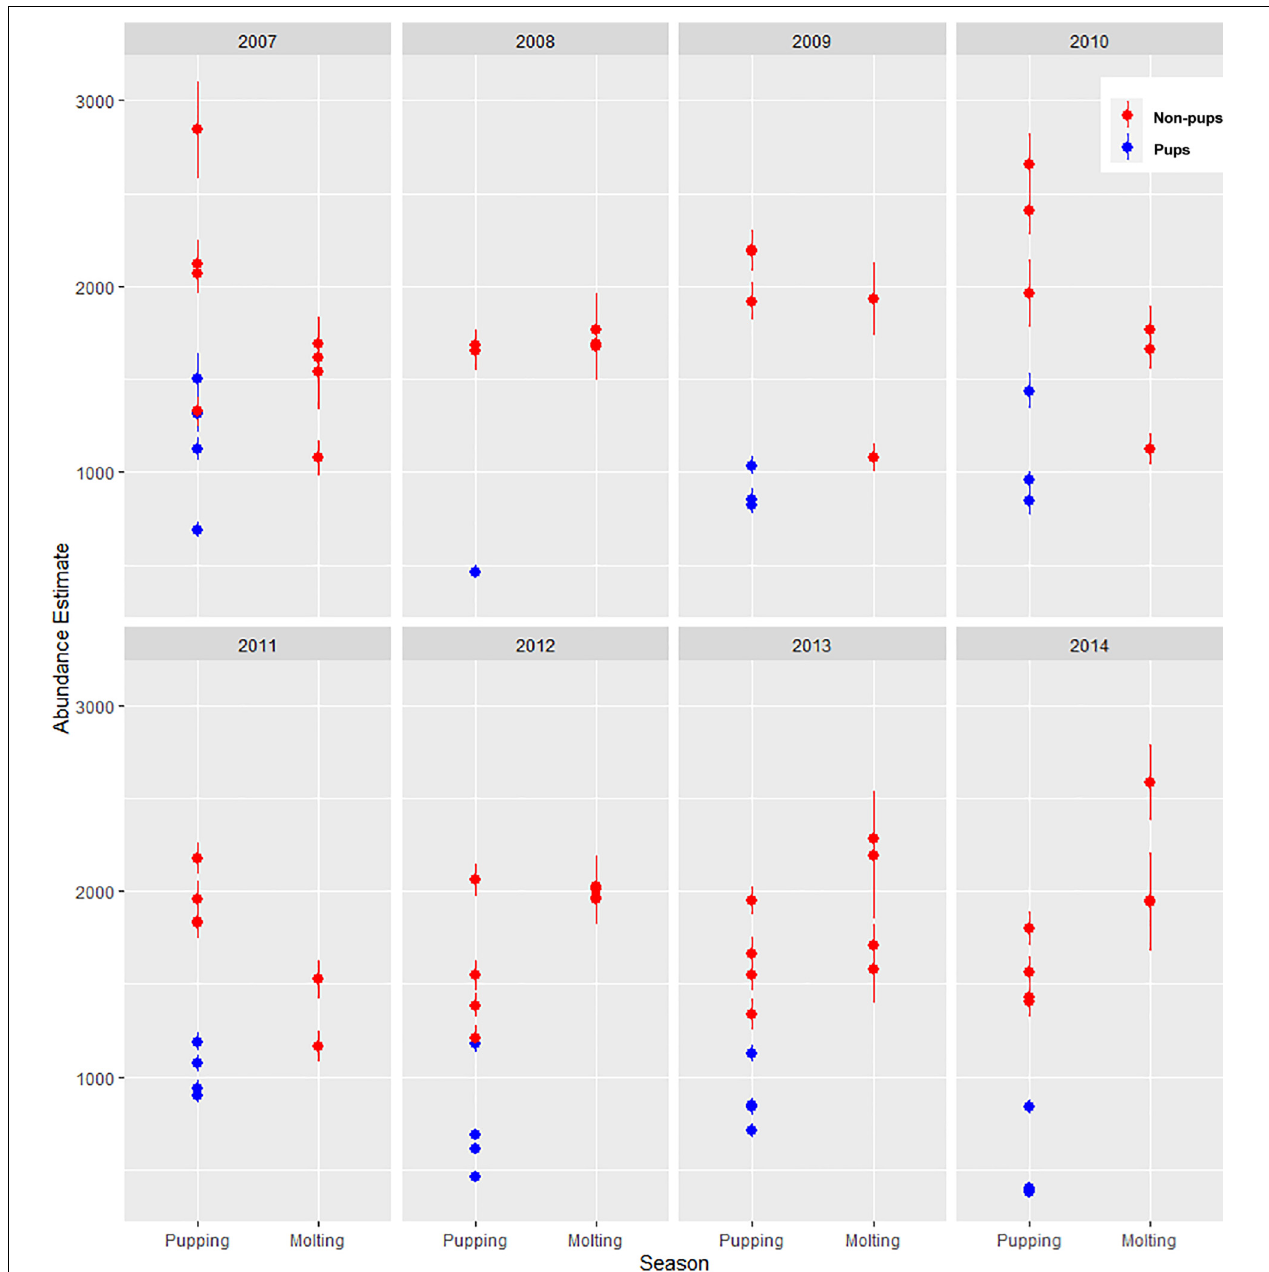
FIGURE 9 | Estimated abundance and standard error of harbor seals non-pups (red circles) and pups (blue circles) in Johns Hopkins Inlet in Glacier Bay National Park in southeastern Alaska based on counts of seals from aerial photographic surveys during the pupping period in June and during the molting period in August from 2007 to